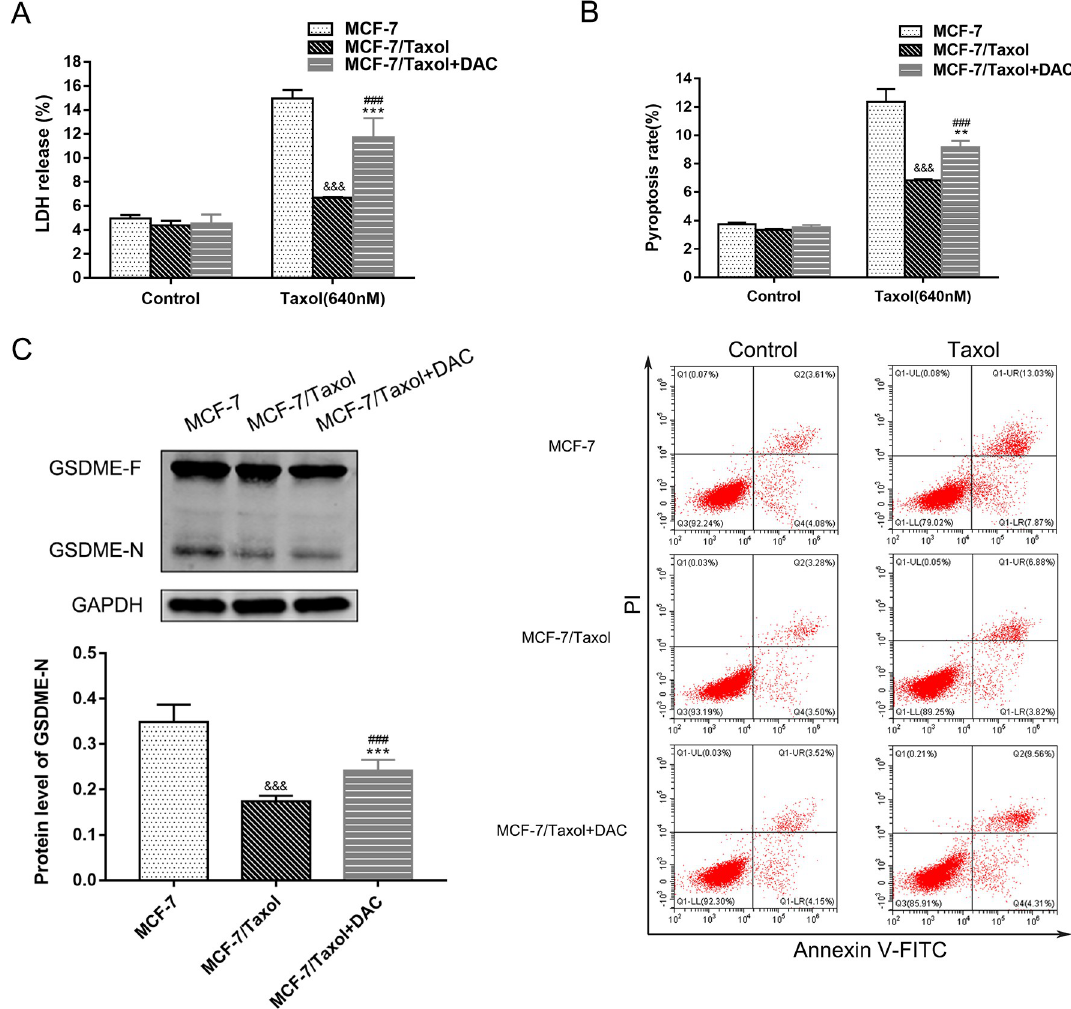
Fig 5. Combined decitabine and Taxol induce MCF-7/Taxol cells pyroptosis. A. The integrity of cell membrane was determined by the LDH release assay of breast cancer cells with 640nM Taxol. B. Flow cytometry was used to detect the incidence of pyroptosis in breast cancer cells treated with 640nM Taxol for 24h. C. The expression of GSDME-N, an active fragment of the key protein of pyroptosis, was detected by Western blot analysis. Data are expressed as the mean ± SD of three independent experiments. �� P < 0.01 vs control group, ��� P < 0.001 vs control group, ### P < 0.001 vs control group, &&& P < 0.001 vs control group.